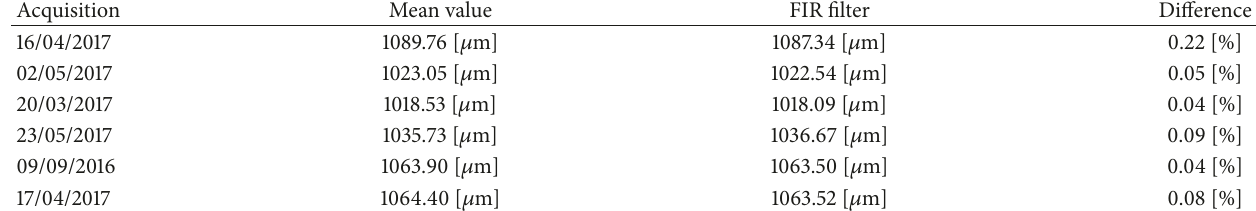
Table 2: DC filtering techniques result.